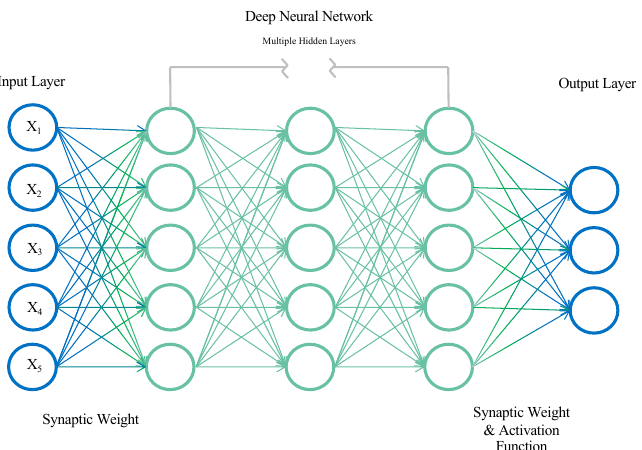
Figure 1. Conceptual diagram of a Deep Neural Network, the arrow depicts the flow of information through which the synaptic weight is